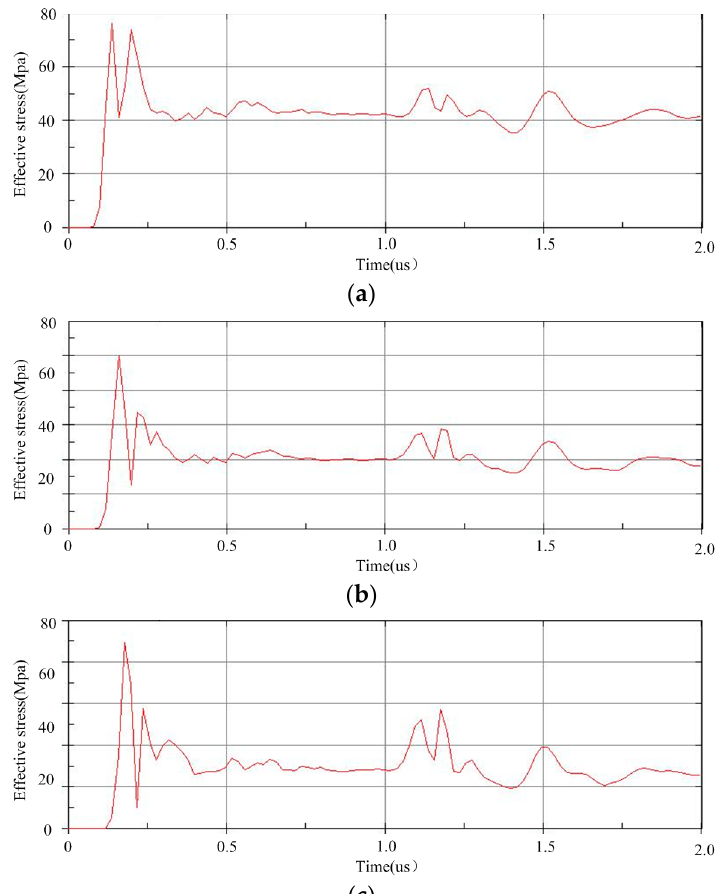
Figure 7. Effective stress curves of monitoring point for different blasting hole spacings: (a) borehole spacing of 0.8 m; ( b ) borehole spacing of 1.0 m; ( c ) borehole spacing of 1.2 m.